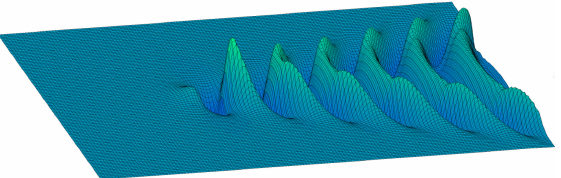
Figure 4. Perspective view of the free surface using Ranking source, for the case F (cid:48) = 0.7 and µ (cid:48) = 0.3, computed on a 151 × 51 mesh with ∆ x (cid:48) = 0.3, ∆ y (cid:48) = 0.3.